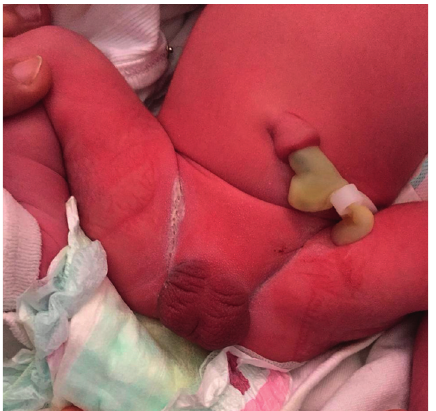
Figure 1: Photograph illustrating aphallia with a normal scrotum.